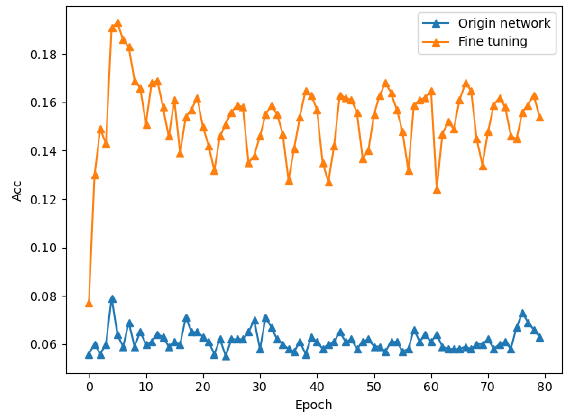
Figure 9. The effect of transfer learning on accuracy.